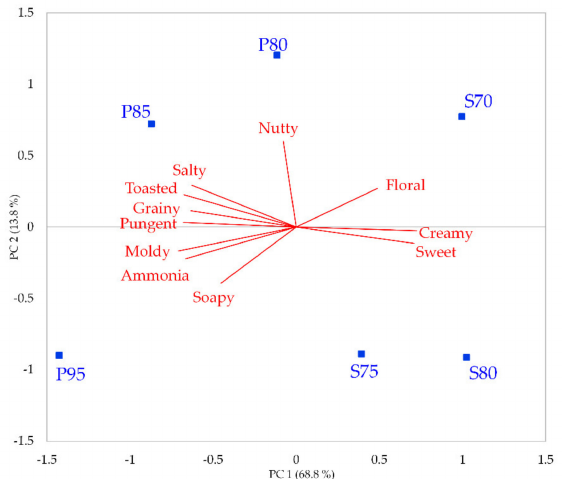
Figure 1. Perceptive map obtained by the PCA applied to the intensity mean values of the 11 sensory attributes evaluated with the RATA test and resulted significant from the ANOVA test ( p < 0.05) (the only non-significant attribute was ‘cooked